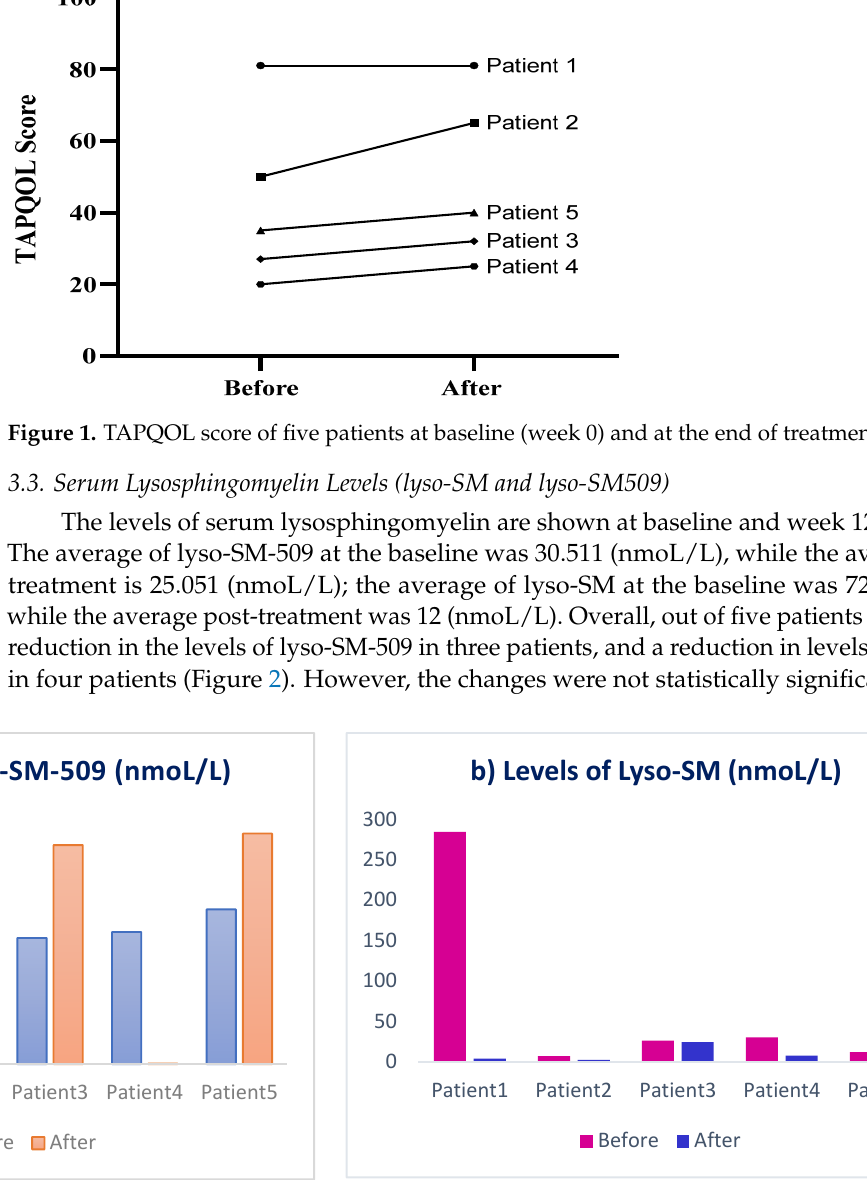
Figure 2. Levels of serum lysosphingomyelin ( a ) lyso-SM509 and ( b ) lyso-SM in patients before and after 3 months treatment with trehalose.